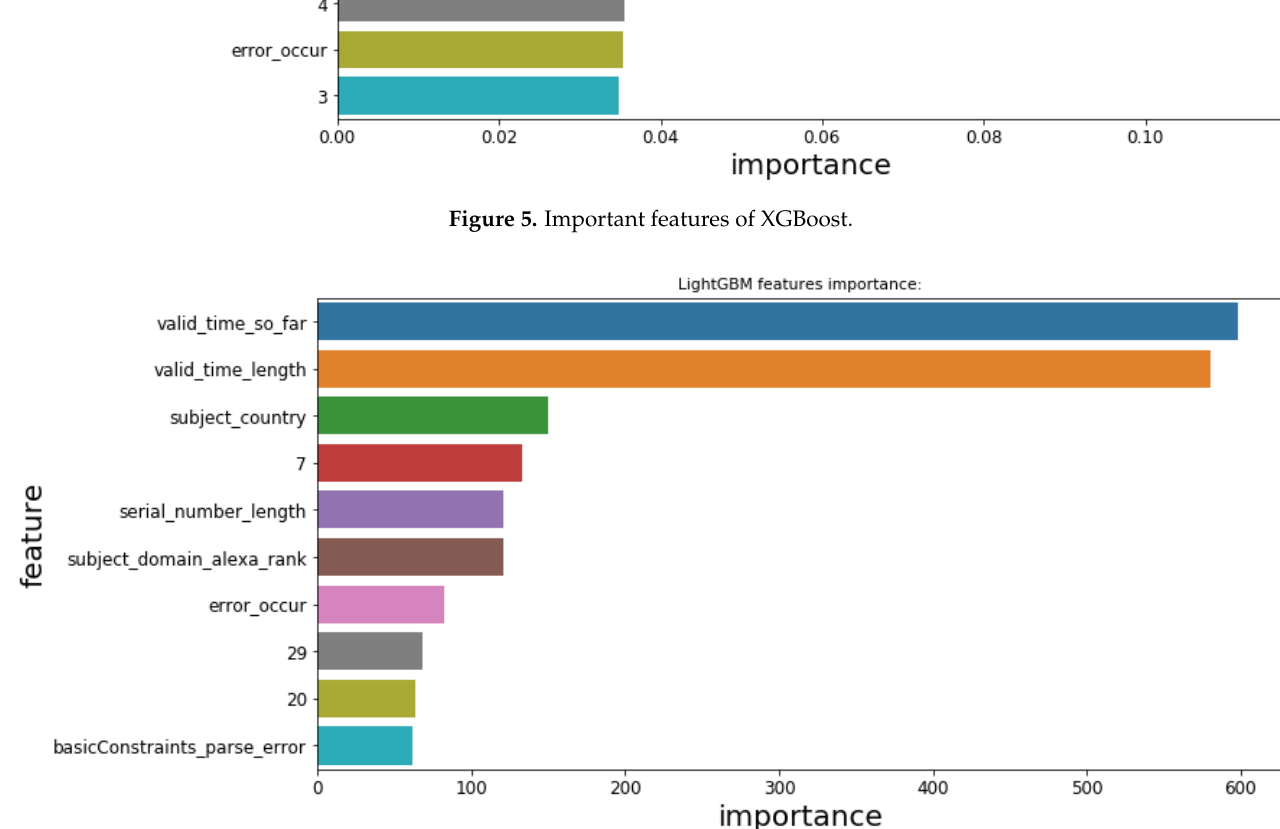
Figure 6. Important features of